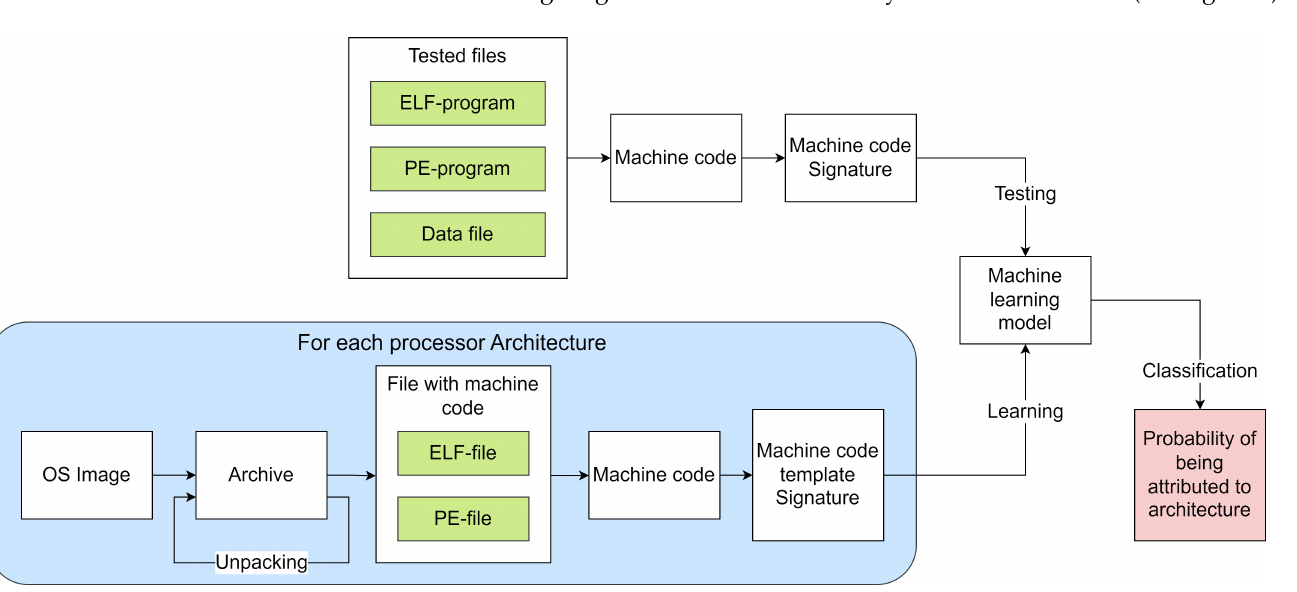
Figure 5. Information layer of identification utility